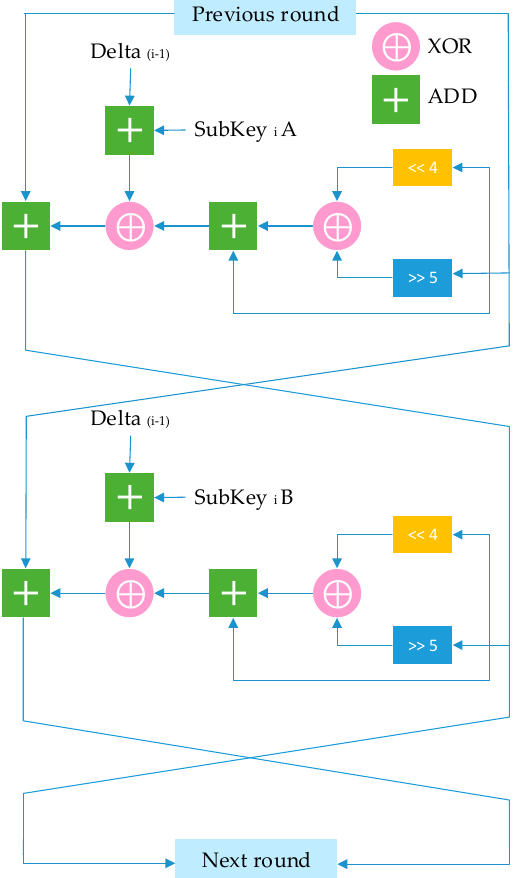
Figure 4. One cycle of XTEA.